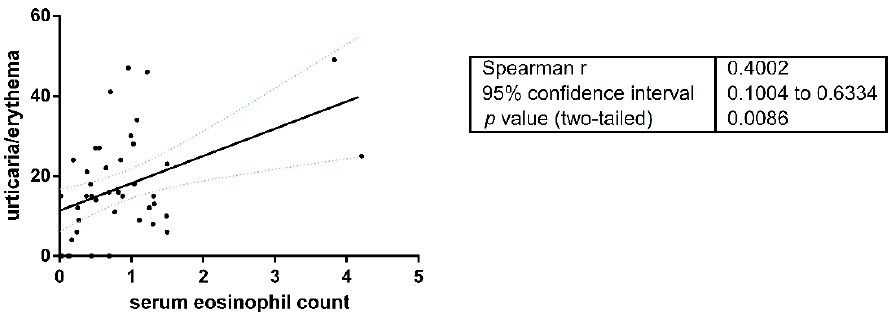
Figure 2. Significant correlation between circulating eosinophil count and BPDAI U/E values, the strength of the associations is expressed as Spearman’s correlation coefficient (r).